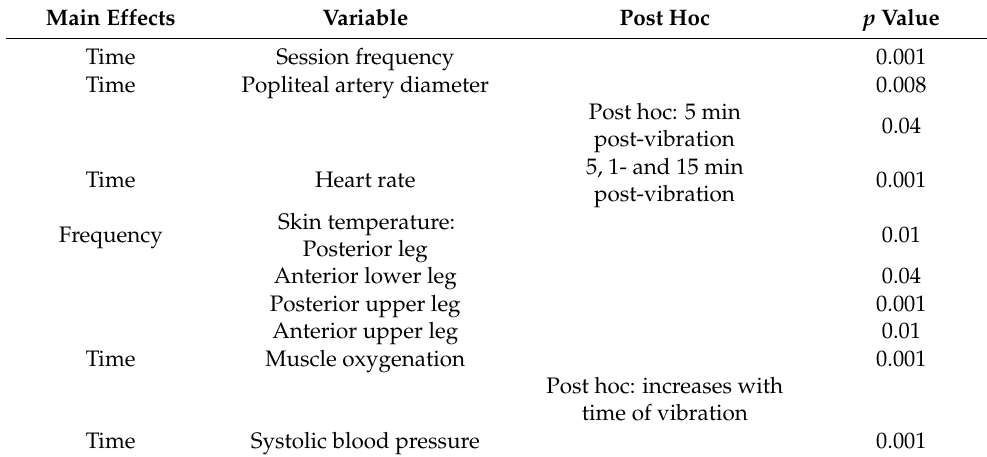
Table 2. Summary of significant